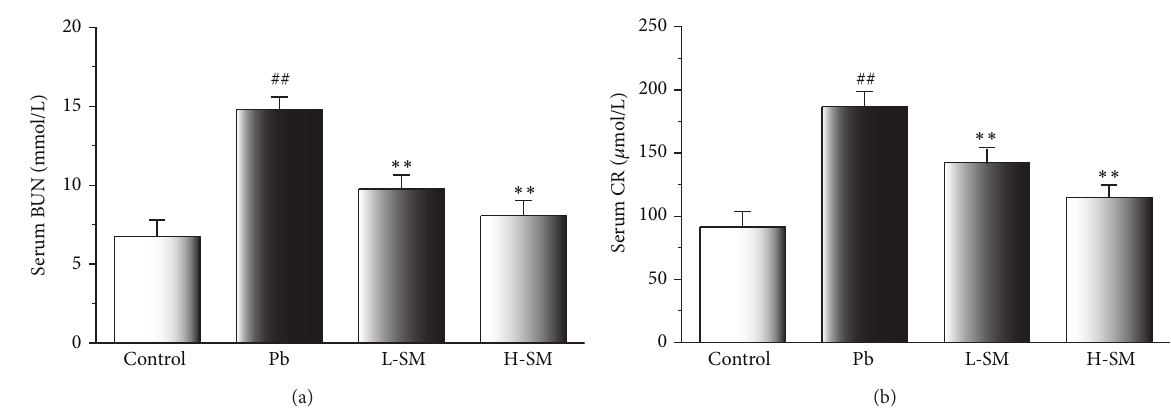
Figure 5: Effects of SM injection on serum concentrations of BUN and CR. Samples were obtained from the control group, Pb group, L-SM group, and H-SM group. Data are expressed as mean ± SD of 20 mice. ## 𝑃 < 0.01 , compared with control group; ∗∗ 𝑃 < 0.01 , compared with Pb